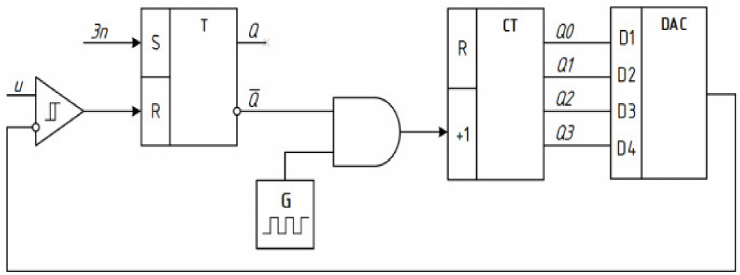
Figure 4. Block diagram of the sequential approximation